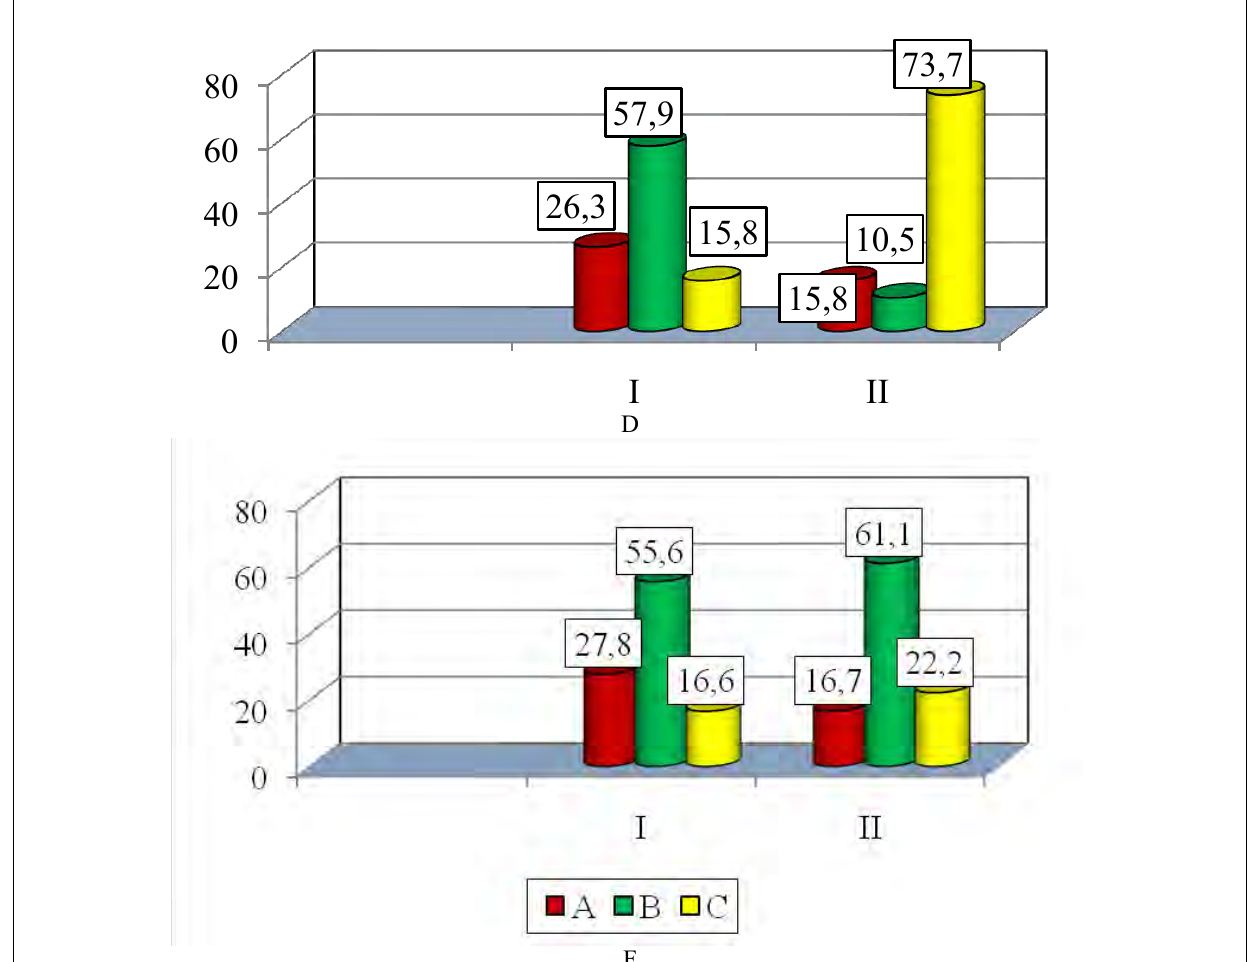
Fig.1. Activity of VNS sections of both groups’ patients in repeated examination (%): І –primary examination; ІІ – repeated